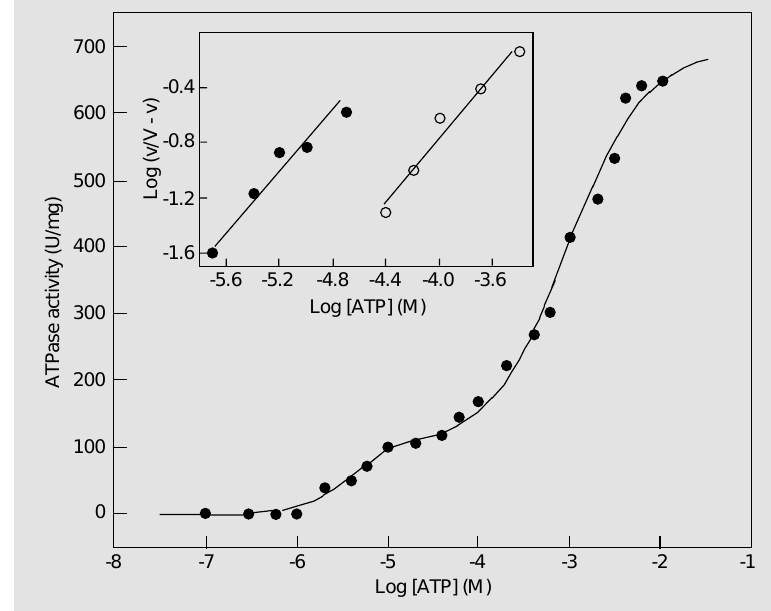
Figure 7. Effect of adenosine 5’-triphosphate (ATP) concentration on ATPase activity of Na,K-ATPase solubilized with C 12 E 8 (1:1, w/w) and purified on a Sepharose 6B column. Assays were buffered with 50 mM HEPES buffer, pH 7.5, containing ATP, 5 mM MgCl 2 , 10 mM KCl and 50 mM NaCl. The reaction was started by the addition of 3.5 µg protein. Inset : Hill plot for the respective results: high-affinity sites (filled circles) and low-affinity sites (open